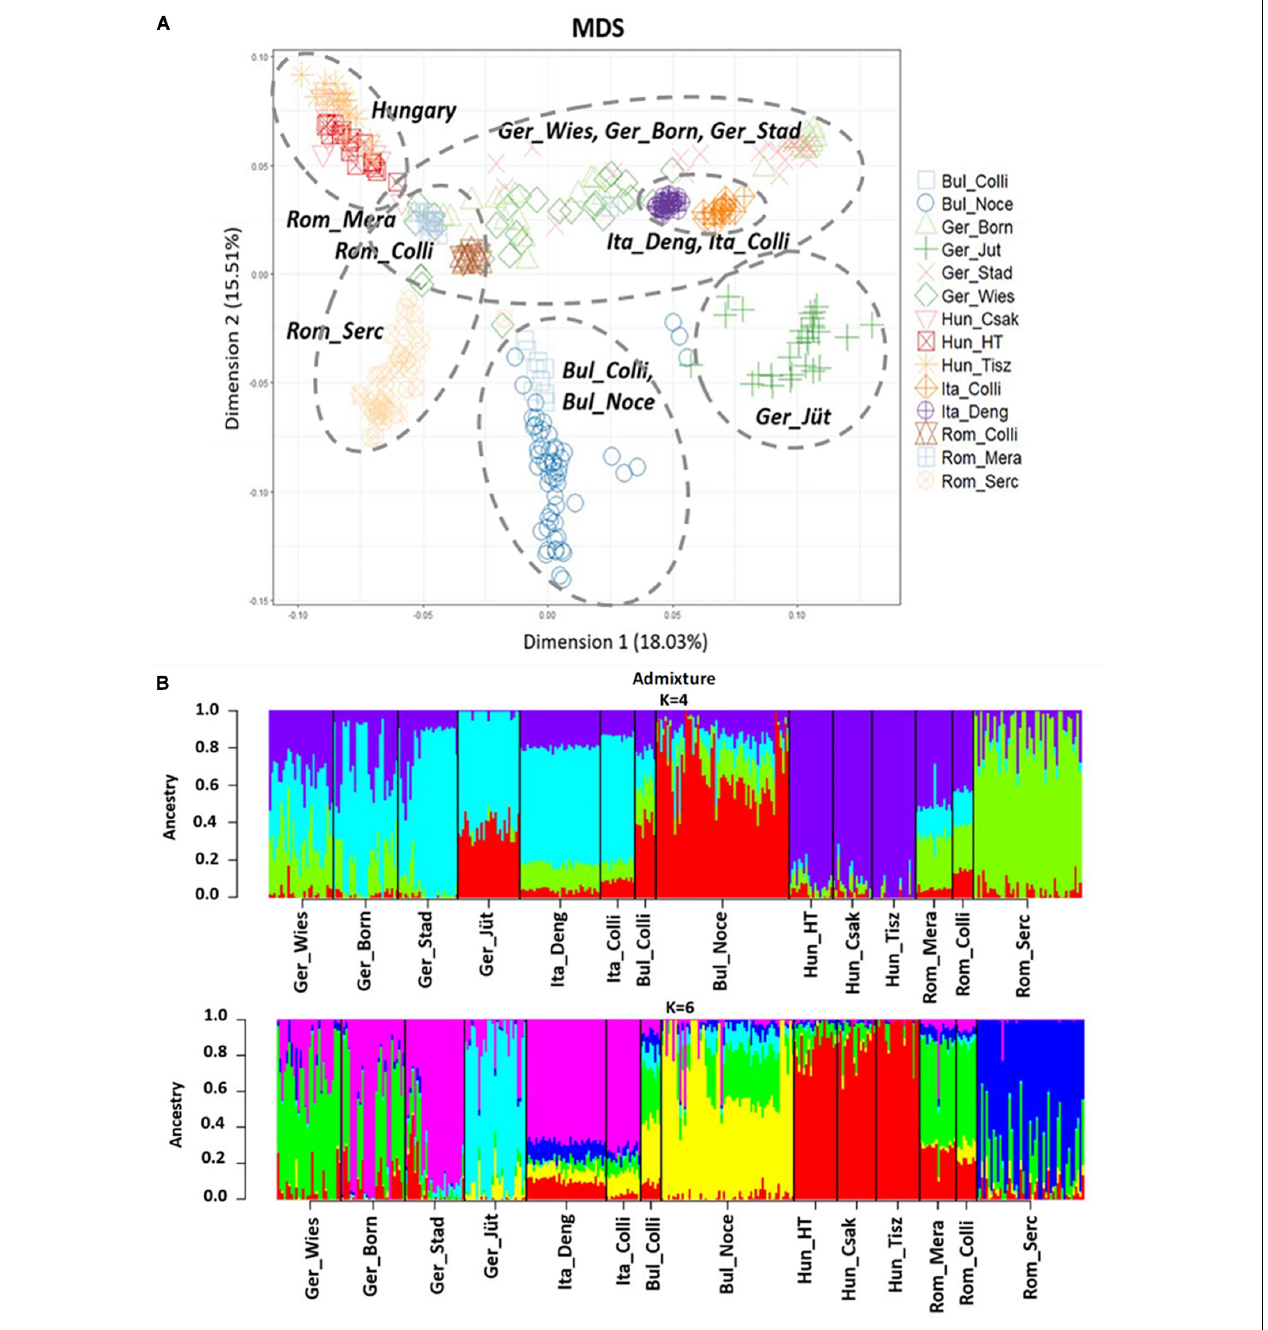
FIGURE 4 | (A) Multidimensional scaling (MDS) plot based on European buffalo populations available in this work. The dashed circles mark the populations that cluster together. (B) Admixture analysis results at K = 4 and 6 exclusively in European buffalo populations. K = 6 was the best fitting solution for the lowest cross-validation error reported (CV = 0.59712). Abbreviations and sample numbers are specified in Figure 3